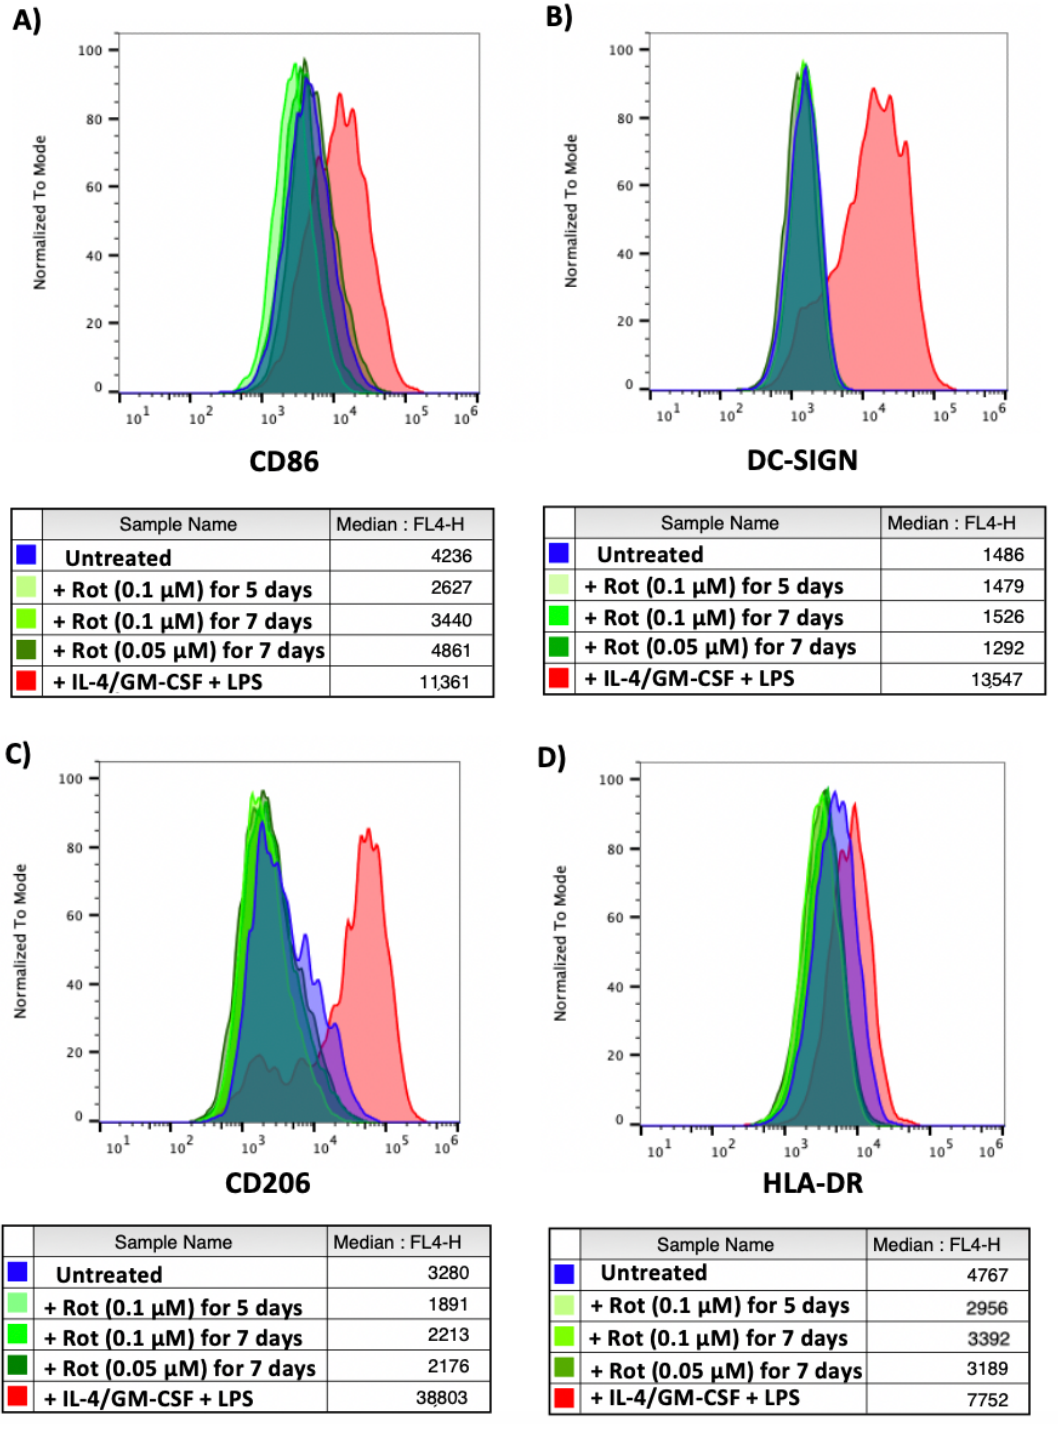
Figure 9. Monocytes treated with rotenone show no signs of differentiation. CD14+ monocytes were left untreated, differentiated and matured with IL-4/GM-CSF + LPS or treated with rotenone for the specified time and concentrations. Monocytes were harvested, stained for ( A ) CD86, ( B ) DC-SIGN, ( C ) CD206 or ( D ) HLA-DR and analysed by flow cytometry. Isotype controls shown in Supplementary Figure S4.